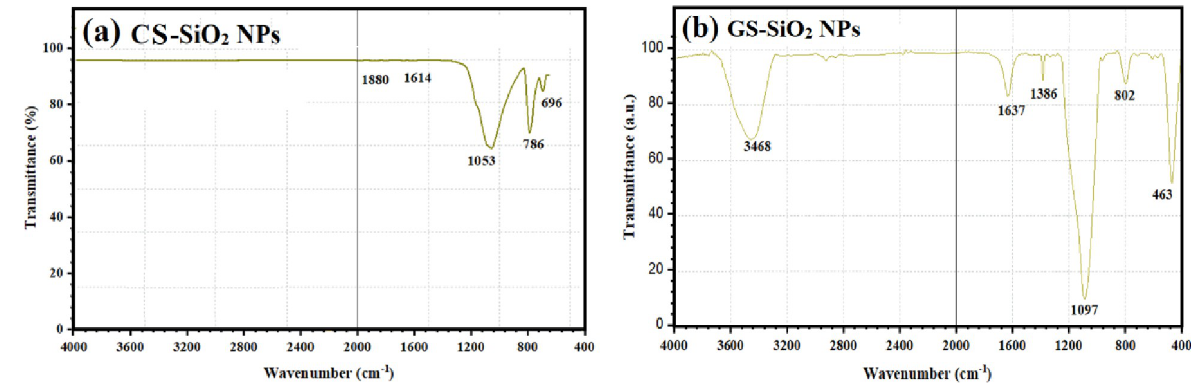
Fig 4. FTIR spectra of (a) CS-SiO 2 NPs and (b) GS-SiO 2 NPs.